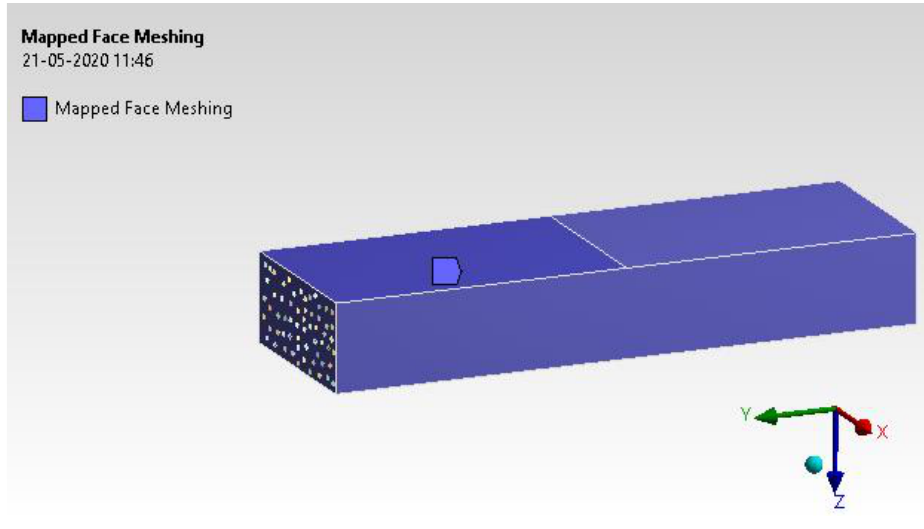
Figure 14. Mapped face meshing.